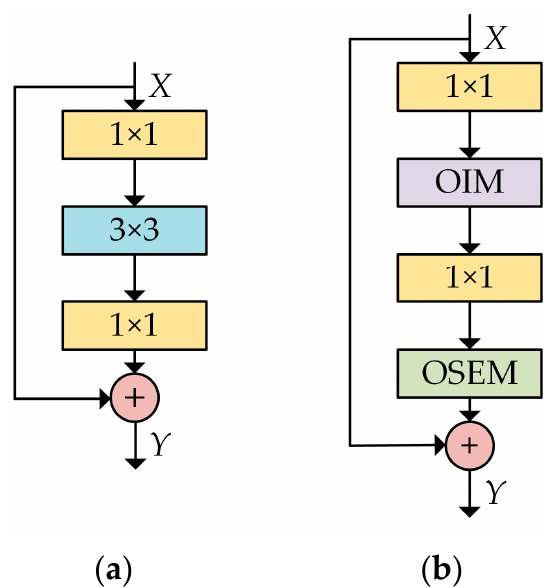
Figure 7. ( a ) The basic block of ResNets; ( b ) the basic block of TL-Nets. The input is denoted by X , and the output is indicated as Y . Table 1. The architecture of TL-Nets for our aerial image dataset. Downsampling is performed